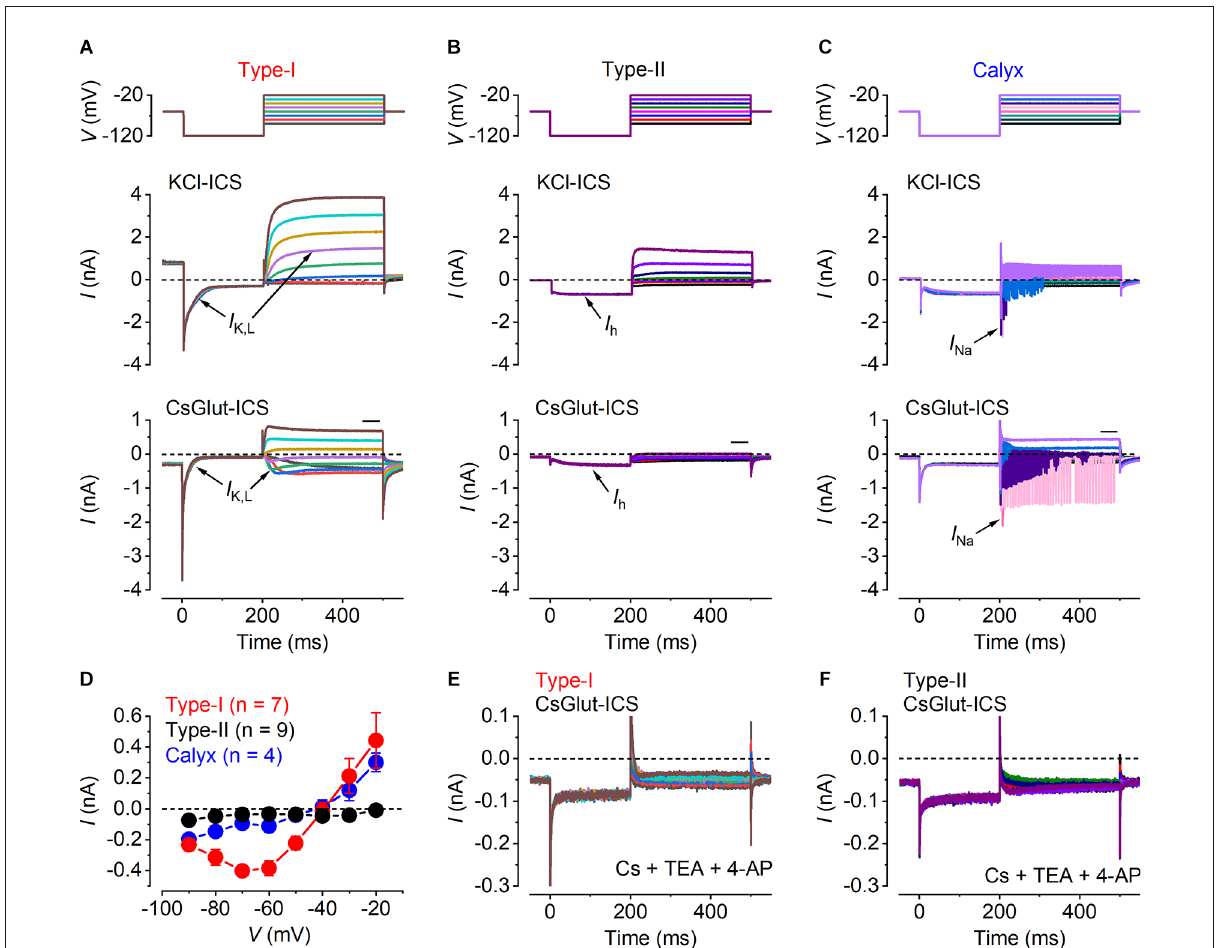
FIGURE1 Identification of vestibular cell types. (A–C) Characteristic whole-cell current responses from a representative type-I hair cell (A) , a type-II hair cell (B) and a calyx afferent (C) . Currents were evoked by 300 ms voltage steps (upper panels), from nominally − 90 mV to − 20 mV, in 10 mV increments, after a hyperpolarizing 200 ms prepulse to − 120 mV, from a holding potential of − 60 mV. Whole-cell current responses obtained using the KCl-based (middle panels) and a CsGlutamate-based (lower panels) intracellular solution. The individual traces are color-coded to match the voltage stimulus in the upper panels. The arrows point to the characteristic currents present in the different cells, including I K,L in type-I cells, I h in type-II cells and I Na in the calyx. (D) Mean steady-state I-V relation for type-I hair cells (red, n = 7), type-II hair cells (black, n = 9) and calyces (blue, n = 4), obtained from the CsGlut ICS recordings by plotting the steady-state current (measured in the region of the horizontal black bar above the test traces in the lower panels of A–C ) against the corresponding membrane potential. (E,F) Residual currents remaining after the local extracellular perfusion of the K + channel blockers CsCl (5.8 mM), TEA (30 mM), and 4-AP (15 mM; see “Methods” Section) onto a type-I and a type-II hair cell, respectively, using the CsGlutamate intracellular